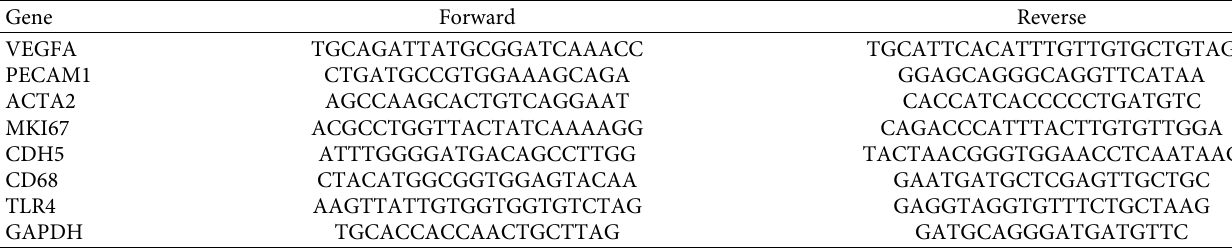
Table 1: The primer sequence for PCR